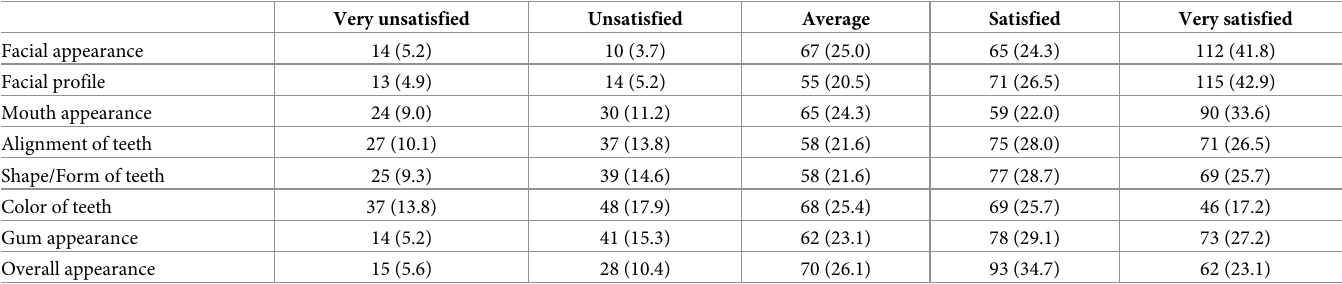
Table 2. Distribution of responses scales according to the OES-Ar items. Very unsatisfied